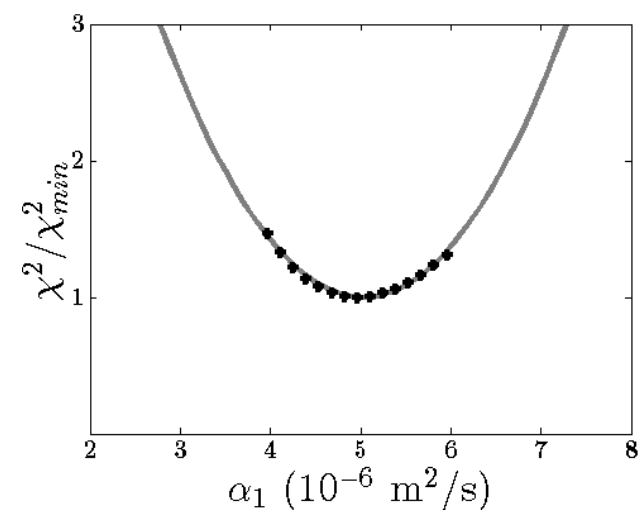
Figure 16. Dependence of the least-squares fitting cost function on the thermal diffusivity of the coating layer, together with its best parabolic fit. For this cost function, only the coating diffusivity was kept as a variable, all other thermoelastic properties of the coating-substrate material were kept fixed. The least-squares cost function shows a unique minimum around the best fitting parameter of α 1 = 5.0 m 2 /s.